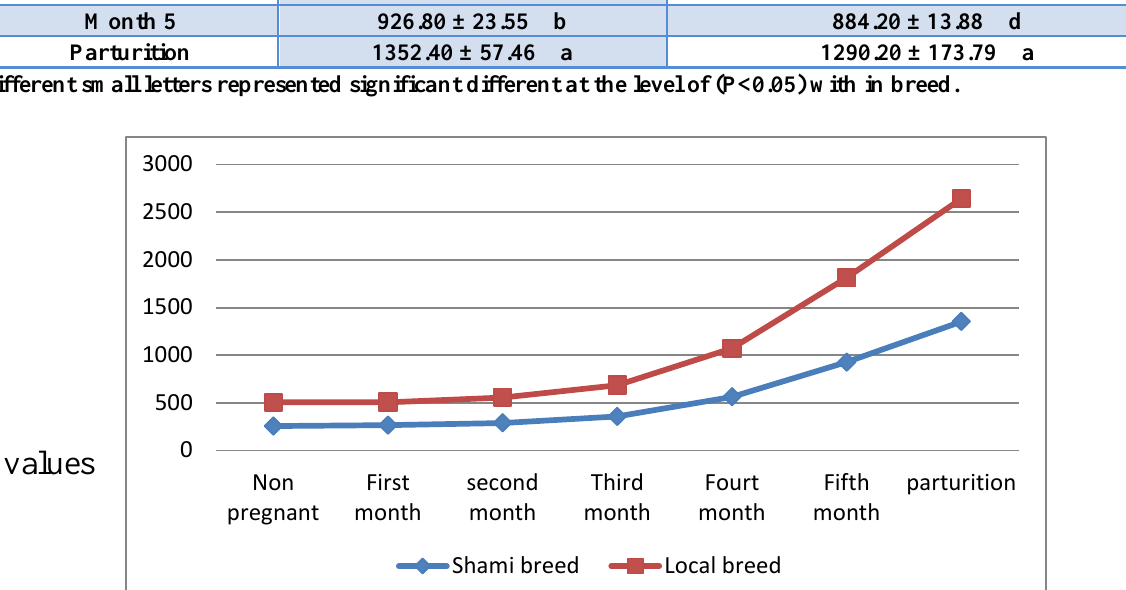
Table, 1: The mean value of oestrogen(E 2 ) in non-pregnancy, pregnancy and parturition inShami and Iraqi goats. Period